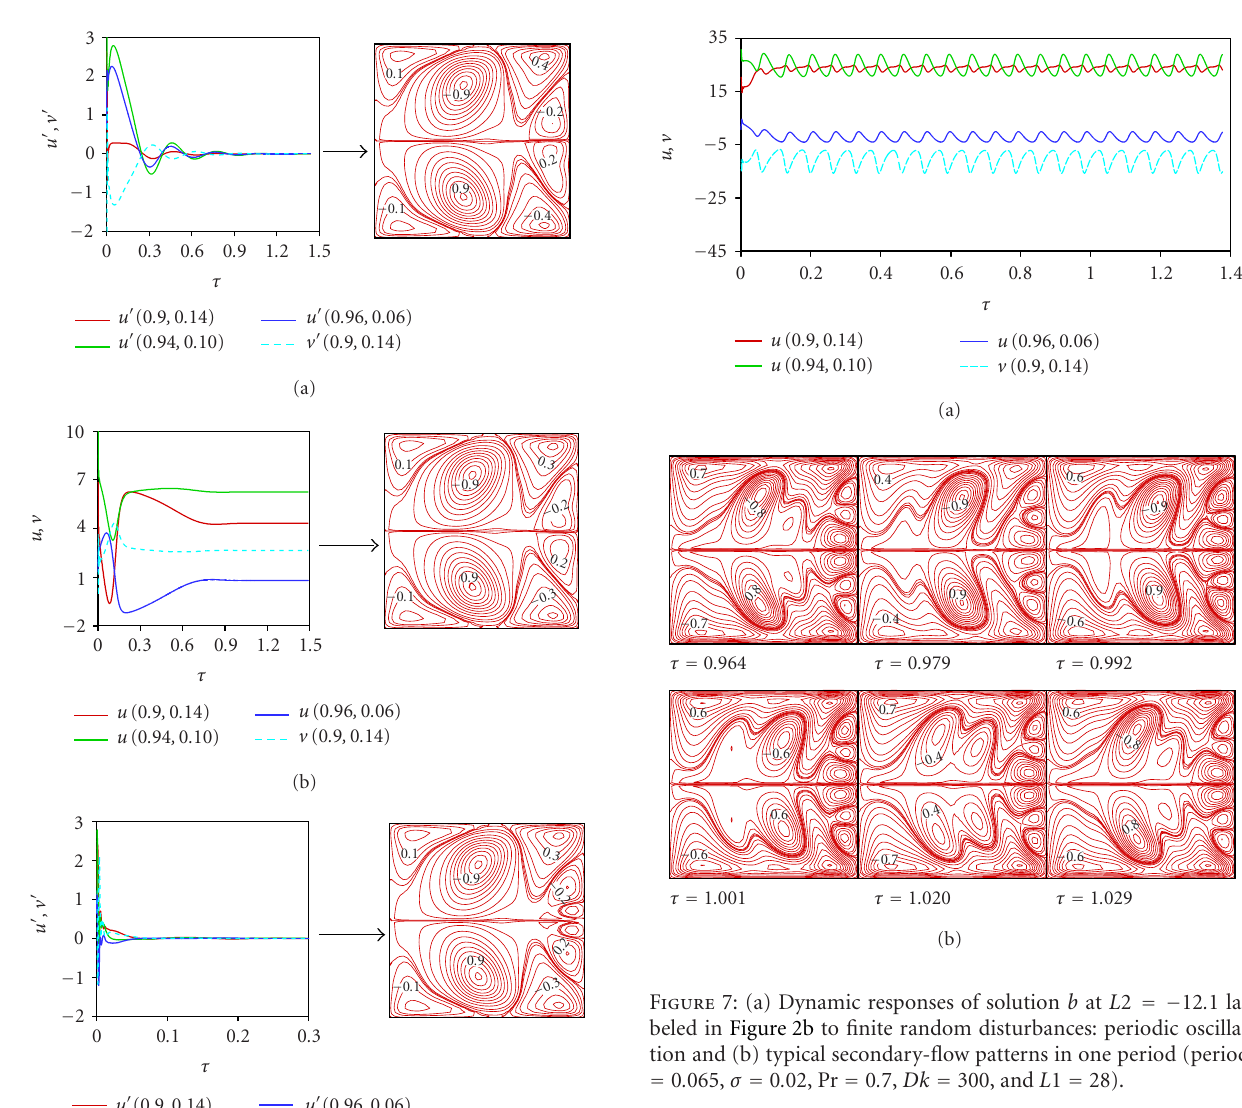
10%. The power spectra of four velocity temporal series in Figure 10 are constructed by the Fourier transformation. They contain the broadband noise, indicating the flow being chaotic [19]. Their sensitivity to the initial conditions further confirms this. The transition from the stable steady flow in L 2 > − 10 . 2 to the chaotic oscillation in − 11 . 5 < L 2 ≤ − 10 . 4 is charac- terized by subharmonic-bifurcation-driven asymmetric os- cillation and shown by the variation of dynamic responses of solutions as L 2 decreases from − 10 . 2 to − 10 . 35 (Figure 11). The power spectra of the velocity temporal series in Figure 11 are constructed by the Fourier transformation and shown in Figure 12. At L 2 = − 10 . 2, the oscillation is periodic and is from the Hopf bifurcation. The frequency f 1 in Figure 12a is